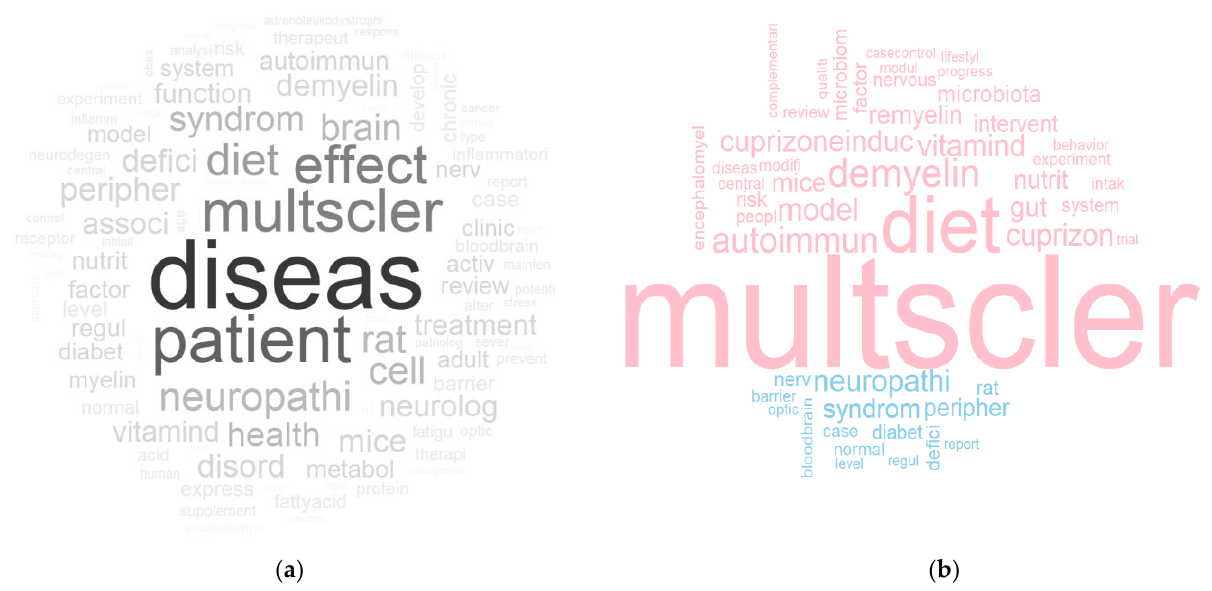
Figure 6. ( a ) The word cloud of omitted articles. More frequently appearing words are displayed with bigger and more opaque fonts. ( b ) The comparison cloud of the four main clusters (pink) and the omitted articles (blue). More frequently appearing words are displayed with bigger font sizes.